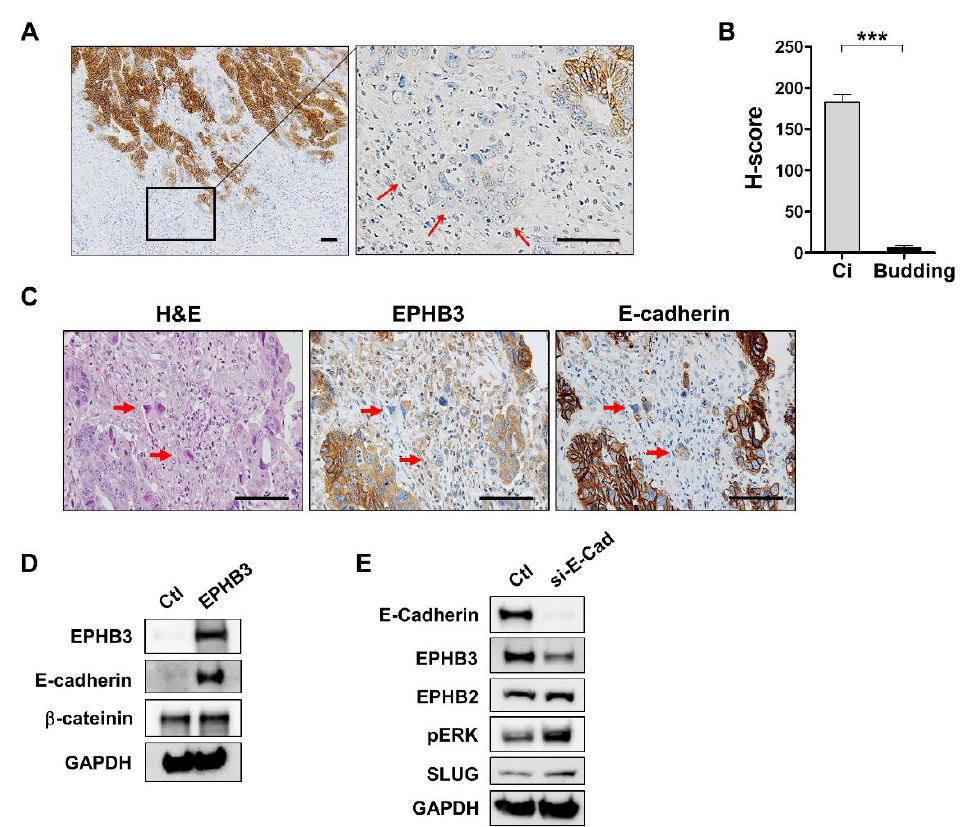
Figure 4. EPHB3 is downregulated in budding cancer cells at the invasive front of CRC tumors. ( A , B ) EPHB3 expression markedly declined in the budding cells at the invasive front of colon cancer tumors ( n = 11), (red arrows). ( C ) At the invasive tumor front, EPHB3 expression decreased more significantly than E-cadherin. Red arrows indicate budding tumor cells that are negative for EPHB3 and E-cadherin. ( D ) EPHB3 overexpression induced E-cadherin expression in DLD1 cells. ( E ) In HT29 cells, E-cadherin suppression by siRNA resulted in the downregulation of EPHB3. Ctl, control; Ci, cancer at invasive fronts; E-cad, E-cadherin. *** p < 0.001. Scale bars: 50 μm.